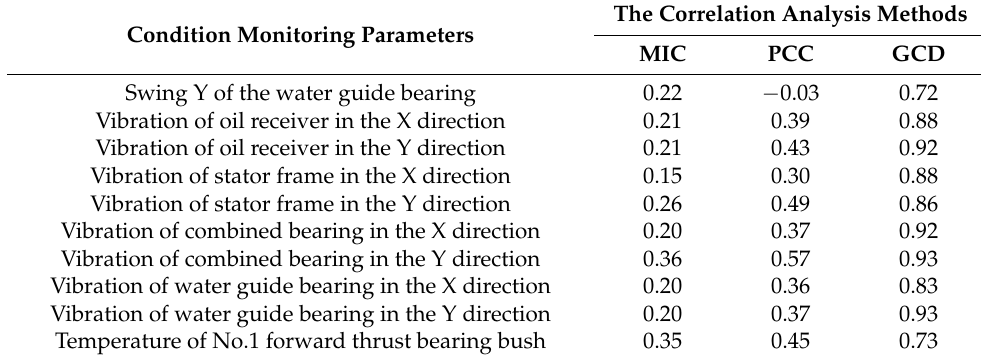
Table 3. Basic dimension parameters of turbine model.